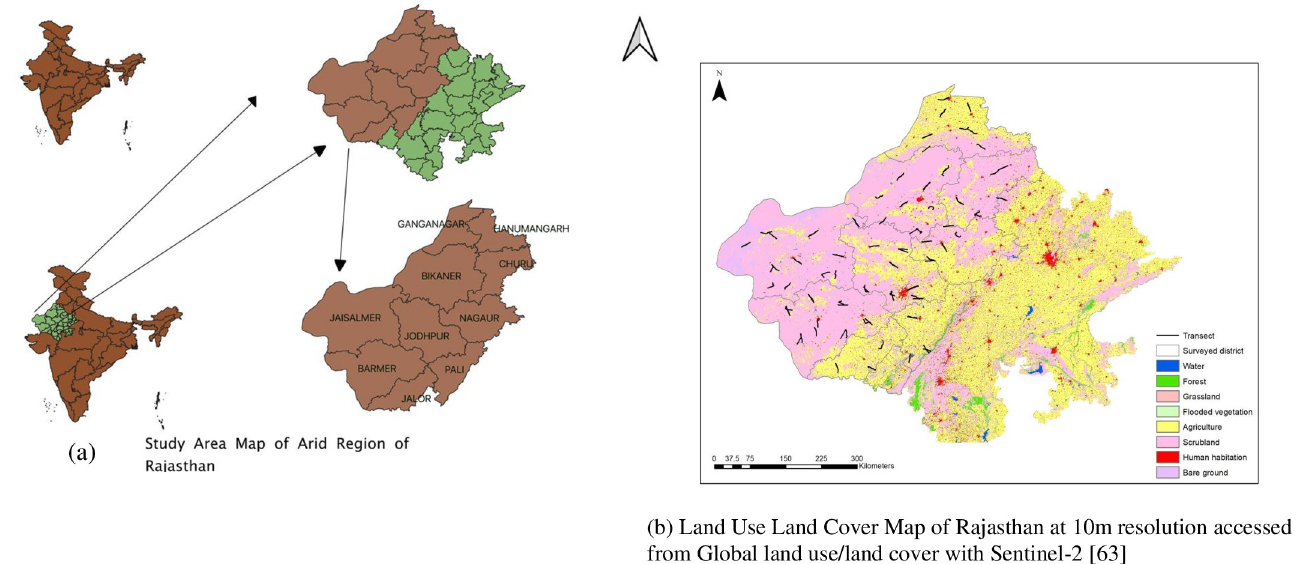
Fig 1. Location map of (a) study area and (b) sampling location in arid region Rajasthan from December 2019 to February 2020.